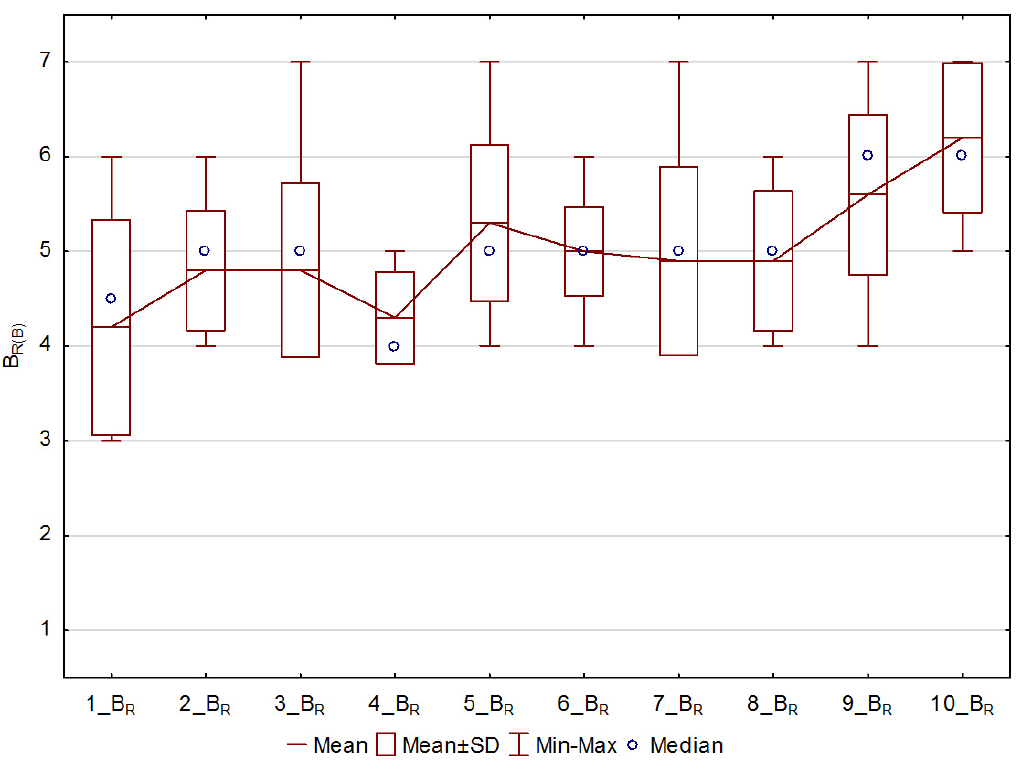
Figure 27. Corridor brightness perception for group B.